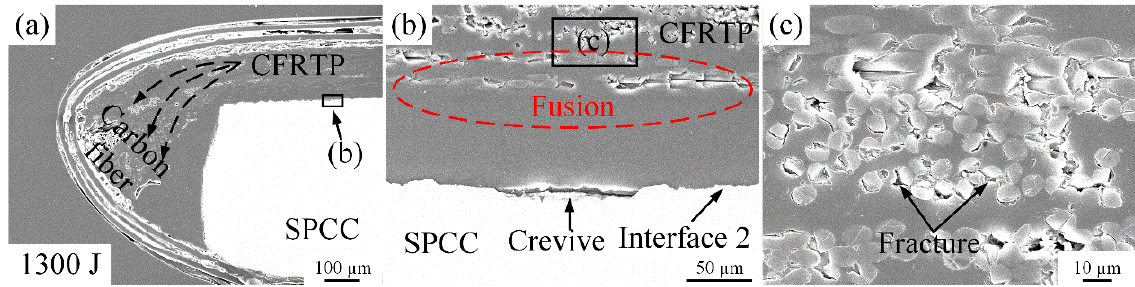
Figure 11. Microstructure of the joint cross-section at the 1300 J energy: ( a ) carbon fibers squeezed out phenomenon; ( b ) situation of interface 1 and 2; ( c ) fractures on carbon fiber.